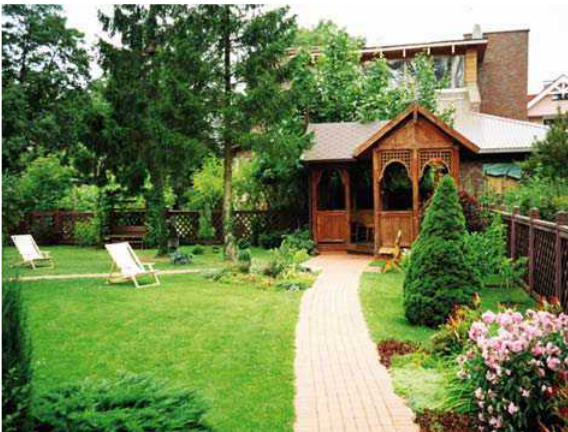
Fig 5. Fragments of surroundings of Villa “Šilelis” in